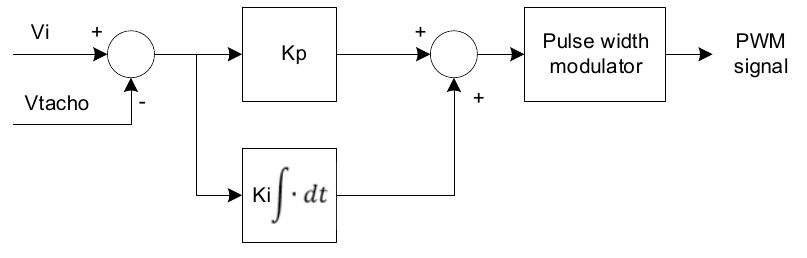
Fig. 5. Block diagram for the PI